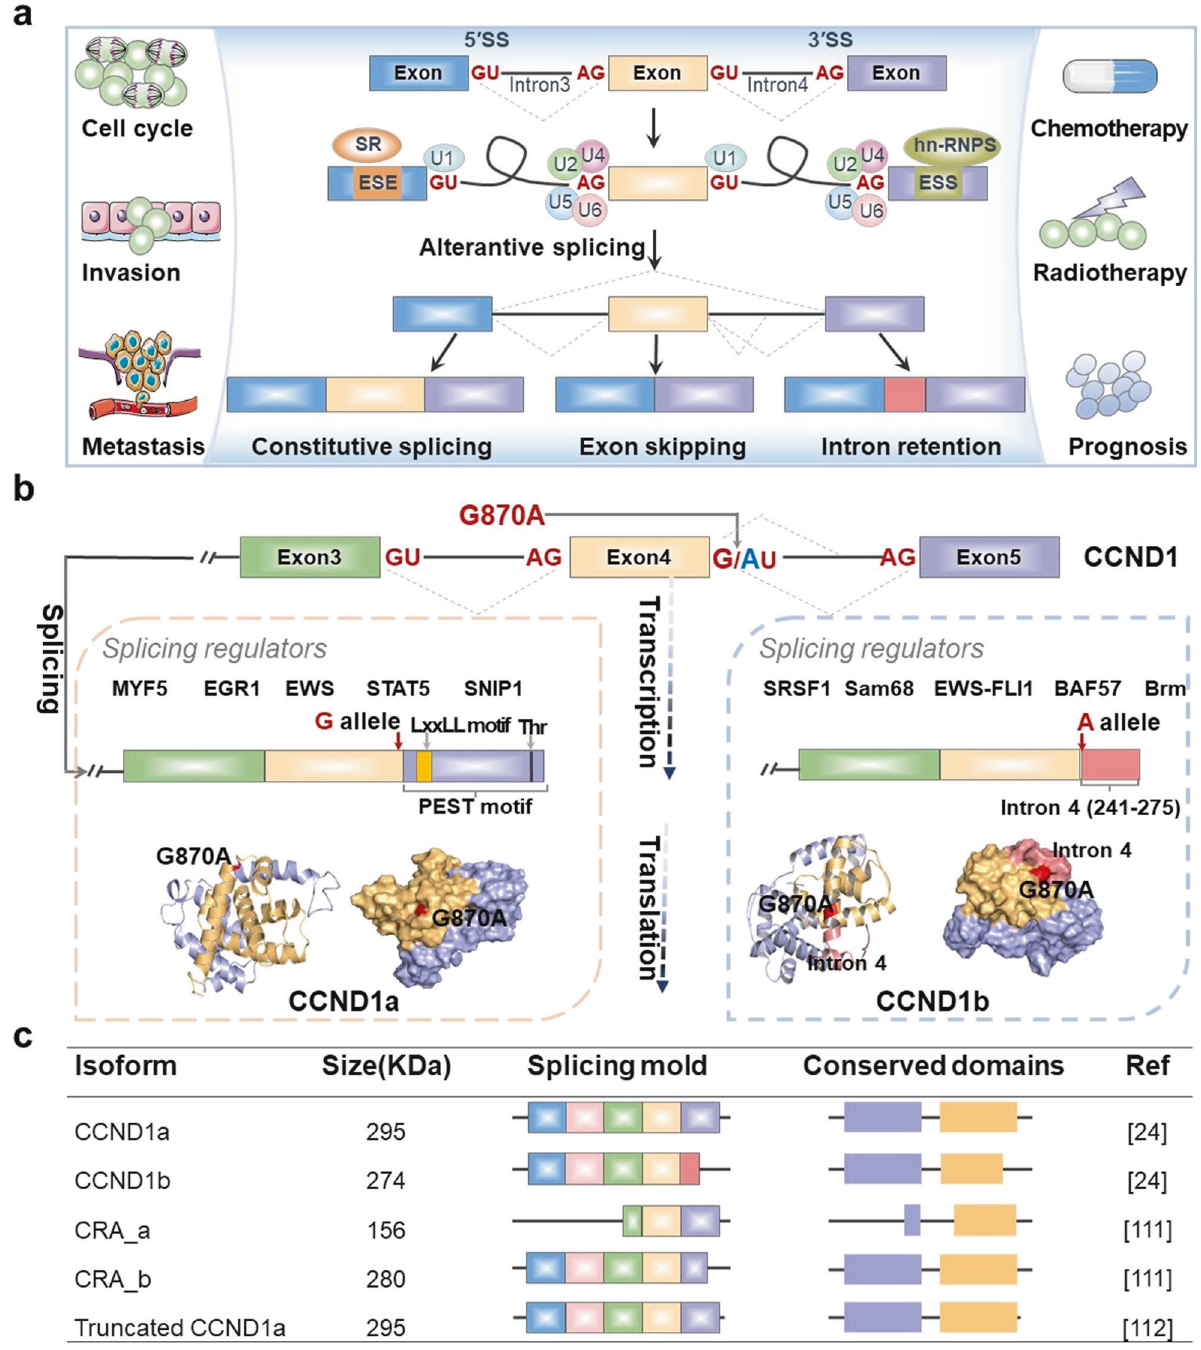
Fig. 2 Regulation of G870A mutation on CCND1 pre-mRNA splicing and splicing isoforms of CCND1. a Alternative splicing and the effect of aberrant alternative splicing on cancer. The Figure shows some examples of cancer-speci fi c alternative splicing events that contribute to the formation of distinct hallmarks of cancer. b The splice mutation of G870A occurs at the classical splice sites of exon 4 and intron 4. Carrying the G allele produces CCND1a. Carrying A allele produces CCND1b. In addition, the combination of cis-regulatory elements and trans-acting factors affects splice site selection. The protein structures of CCND1a and CCND1b are signi fi cantly different, and the mutation site is indicated by red. c General structure characteristics of CCND1